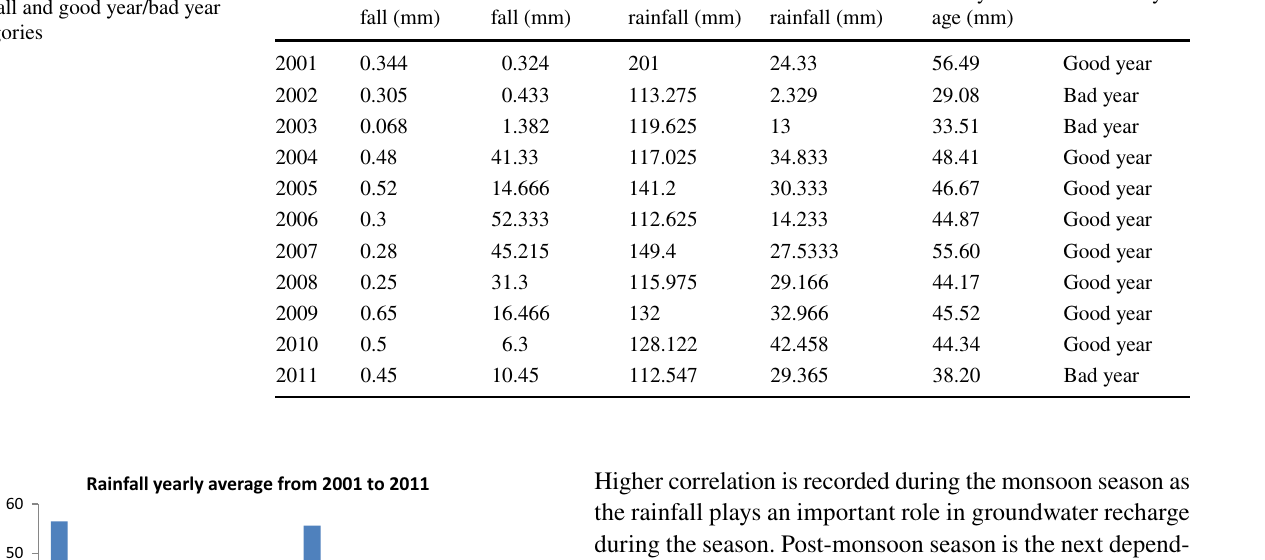
Table 3 Season-wise average rainfall and good year/bad year categories